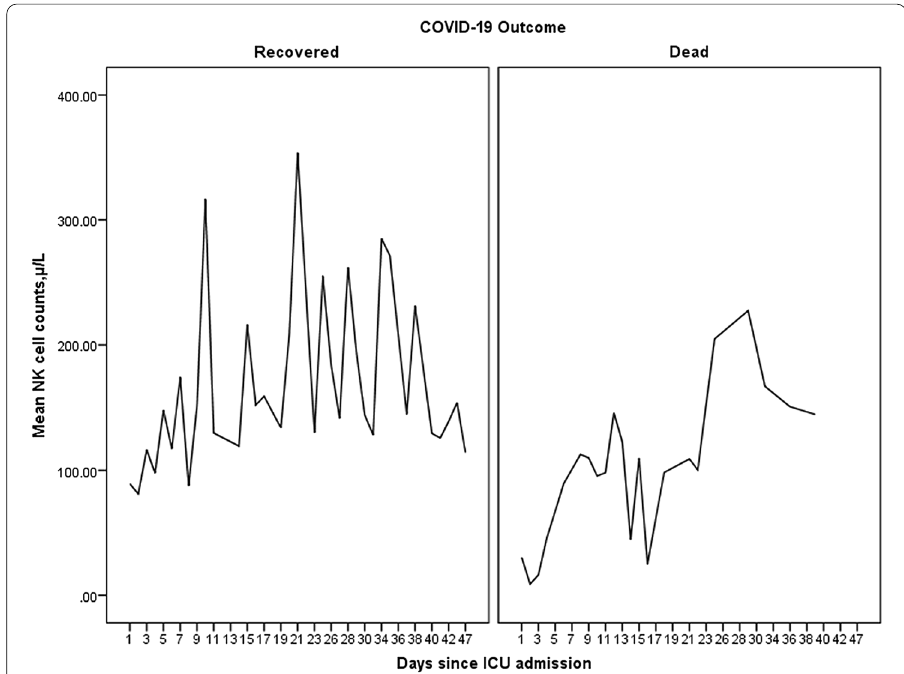
Fig. 1 Mean natural killer cell count over whole observational period according to patient outcome. Outcome related mean natural‑killer cell counts over whole observational period showing higher natural killer cell counts in patients who recovered from severe COVID‑19 compared to patients who